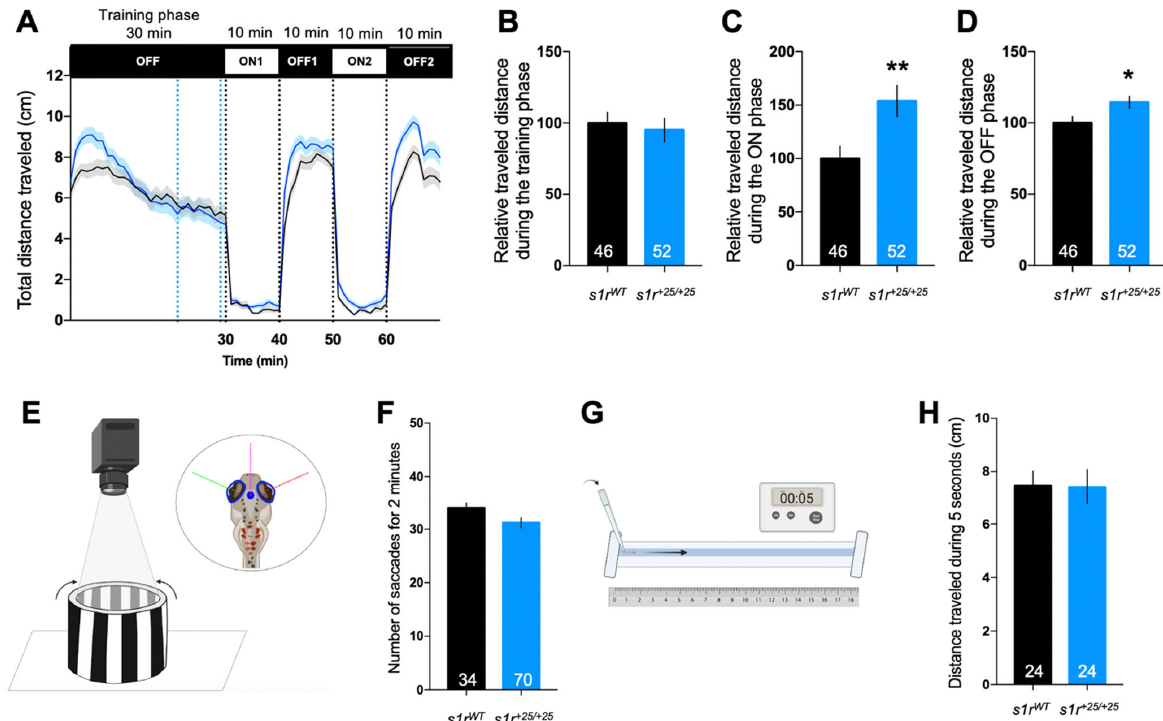
Figure 2. Behavioral analyses of 5 dpf s1r mutant larvae. ( A ) Analysis of the distance traveled by the larvae during the light/dark (intensity 100%/0%) cycle in the VMR test. The activity was measured for 70 min with a training phase of 30 min in the dark (OFF 0%), then two cycles of light/dark (ON 100%/OFF 0%) of 10 min each. The graph shows the distance traveled per min for s1r WT and s1r +25/+25 larvae. ( B ) Relative distance traveled during the training phase [blue dotted lines in ( C ), between 21 and 29 min]; ( A ) during the ON phase [the averaged ON1 and ON2 phases]; ( D ) during the OFF phase [the averaged OFF1 and OFF2 phases]. Relative distance was expressed as % of controls. ( E ) Illustration of the OKR test. ( F ) Quantification of the number of saccades performed in 2 min. ( G ) Illustration of the touch escape test. The larva was placed in a rail filled with E3 medium, the tail was touched with a tip and the distance was measured. ( H ) The distance traveled was measured during 5 s, repeated three times per larva and averaged. Data show mean ± SEM from three replicas. The number of animals is indicated within the columns. * p < 0.05, ** p < 0.01; unpaired t ‐ test.